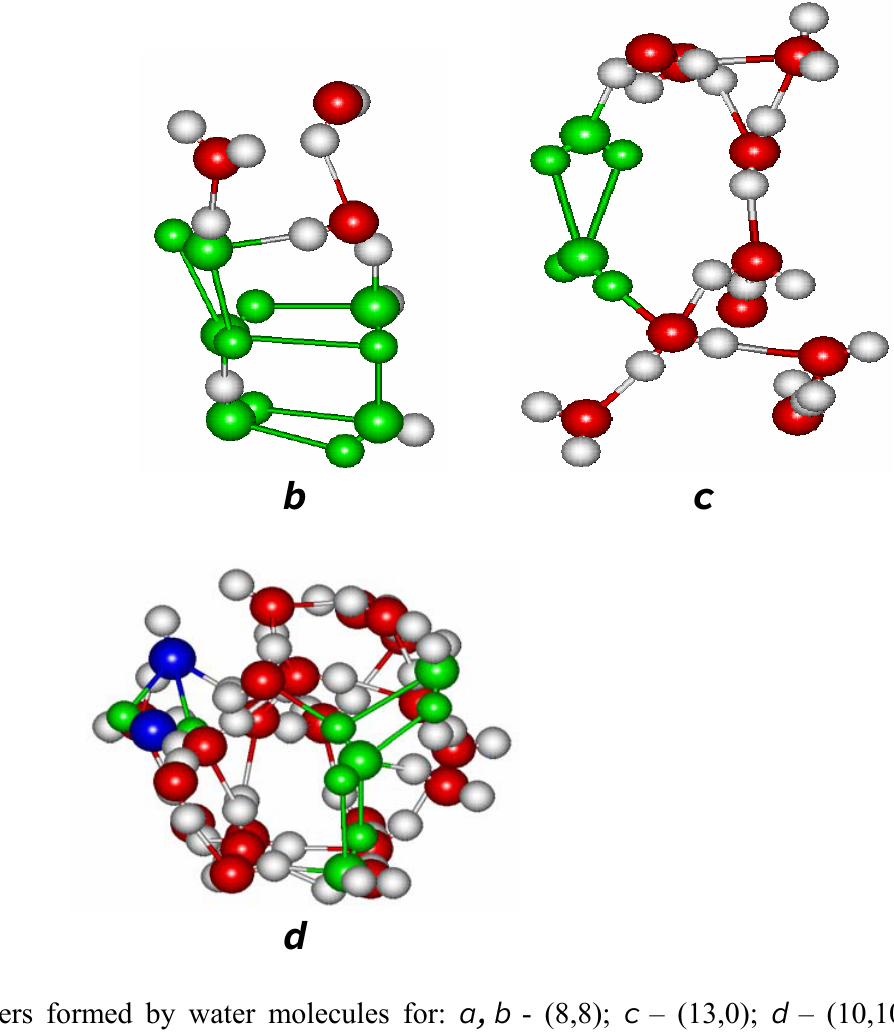
Figure 6. The inner clusters formed by water molecules for: a, b - (8,8); c – (13,0); d – (10,10) nanotube immersed in water. BD and ID associates are marked by color.